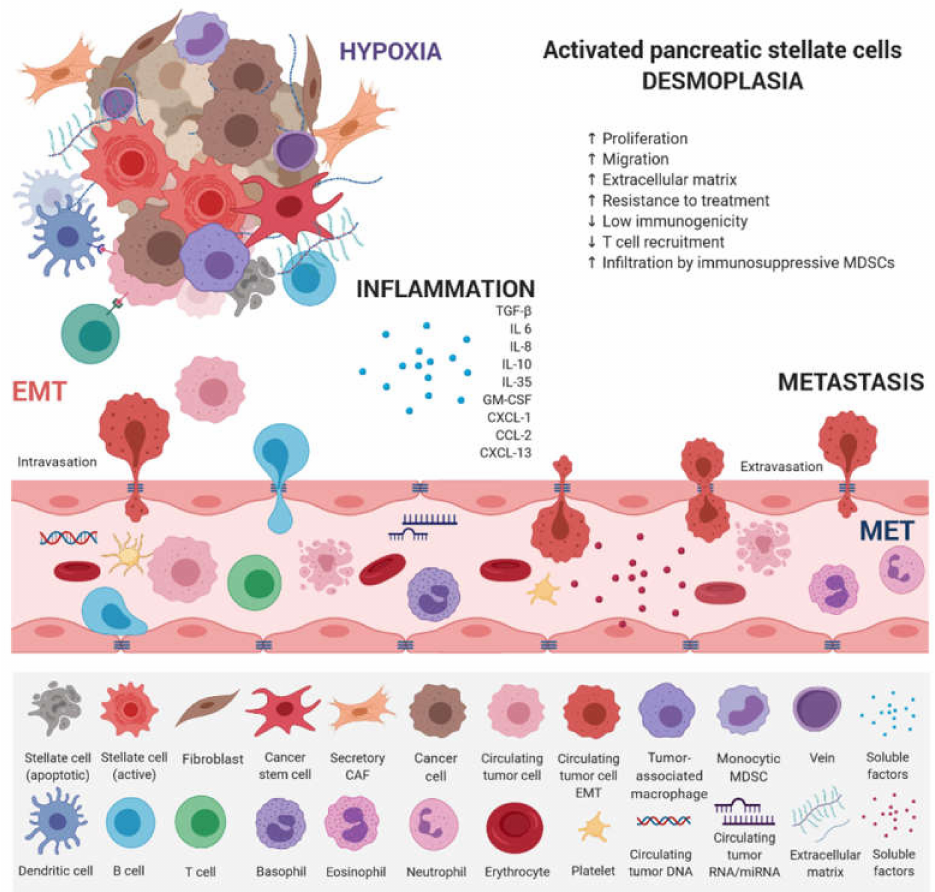
Figure 2. Main factors that influence PDAC progression. PDAC consists of a minority of malignant cells within a microenvironment composed of an extracellular matrix (ECM) and a plethora of hematopoietic cells. Pancreatic stellate cells activated from the quiescent state by intrinsic and extrinsic stimuli (e.g., mechanical injury or chronic inflammation) play a key role. Once activated, they secrete an abundant amount of ECM proteins composed of hyaluronan, laminin, fibronectin, and collagens. By secreting ECM proteins, cytokines, and chemokines, they actively recruit monocytes and CD4 regulatory T cells (Tregs). Hematopoietic cells are predominantly of the myeloid lineage, with both granulocytic and monocytic myeloid-derived suppressor cells (MDSCs), as well as tumor-associated macrophages (TAMs). All contribute to local immunosuppression. KRAS mutation is an early oncogenic event that drives the recruitment of B cells early in the development of PDAC, which can exert immunosuppressive e ff ects. Therefore, T cells, both CD4 + and CD8 + , are not primed against PDAC antigens and are not excluded from tumors. The paucity of blood vessels leads to high levels of hypoxia in the interior of the tumor. Paracrine interactions between inflammatory cells and hypoxia stimuli induce EMT, which promotes circulating tumor cell (CTC) formation and endows di ff erentiated normal and cancer cells with stem cell properties. They are characterized by a high expression of drug e ffl ux pumps including multi-drug resistance genes, protecting them from chemotherapeutic reagents thus increasing their metastatic